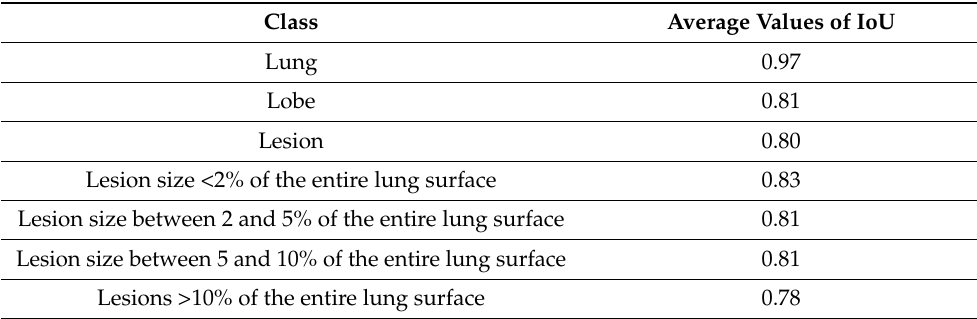
Table 2. Test set. Intersection over Union. Performances of the DL-based method with respect to the veterinarians’